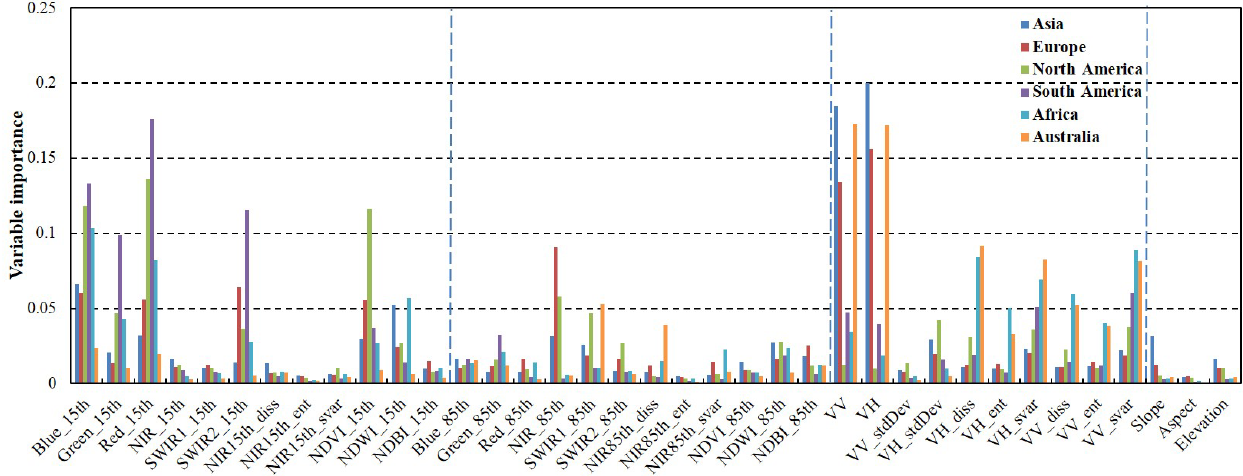
Figure 3. The importance of the input features derived from the random forest model using the training samples in six continental